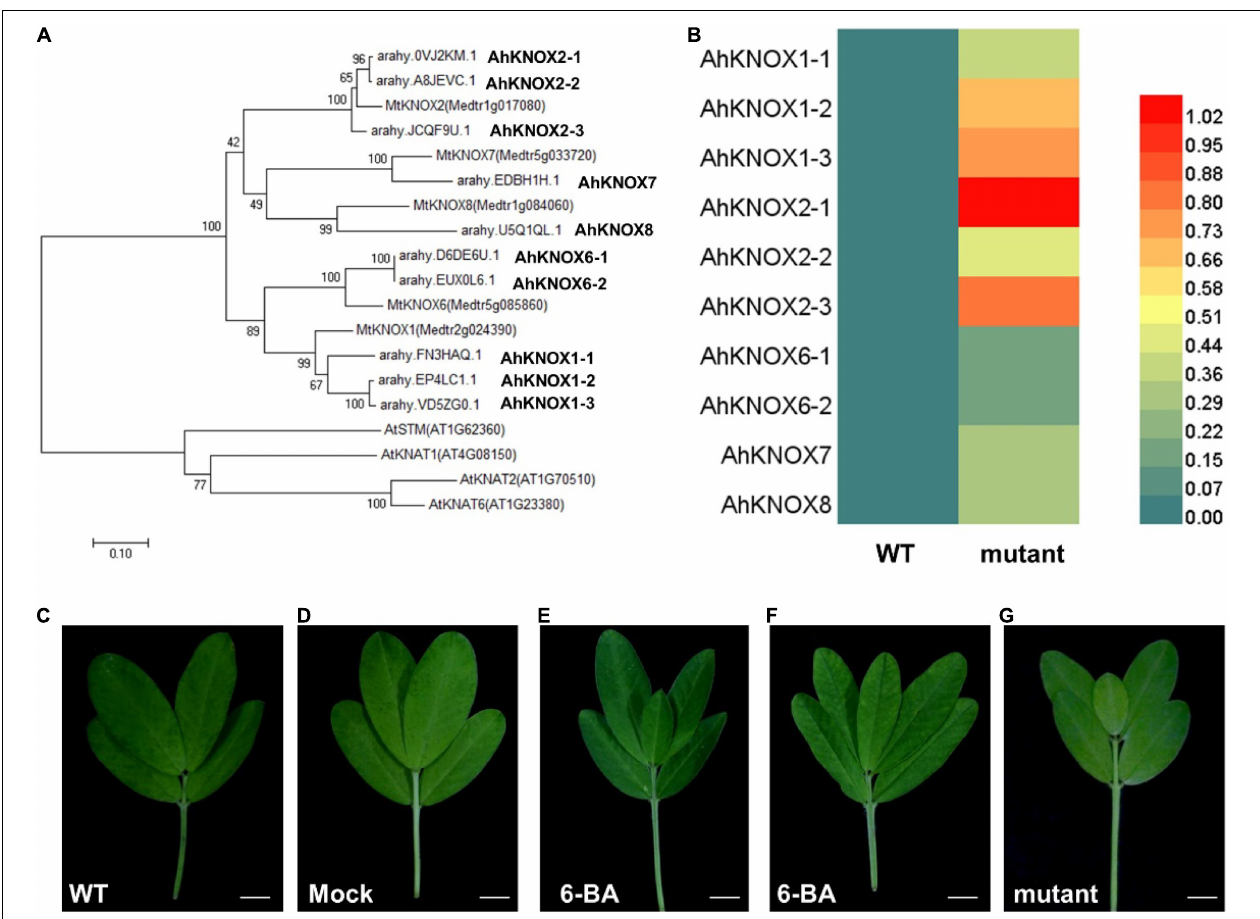
FIGURE 5 | AhKNOXI and CK are involved in the compound leaf pattern of A. hypogaea. (A) Phylogenetic analysis of KNOXI genes in A. thaliana , M. truncatula , and A. hypogaea . (B) A heatmap analysis of AhKNOXI genes expression in wild type and mutant. (C) Adult leaf of wild type. (D) Adult leaf of wild type treated with the same concentration of Tween 20 as control. (E,F) Adult leaves of wild type treated with 6-benzyladenine (6-BA). (G) Adult leaf of the pentafoliate mutant. Bar = 1 cm (C–G)